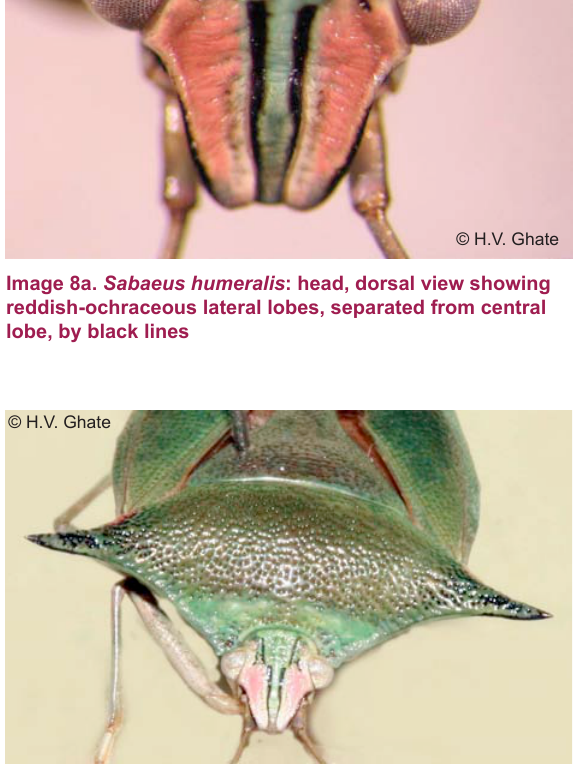
parts of scutellum, are dark black. The area between punctures shining green, almost like beetle elytra. Spines of the lateral pronotal angles are green with black tips and possess a reddish ochraceous spot at the posterior margin (Image 9). Ventrally these spines are smooth, pale green and with black tips (Image 10). Scutellum narrowed towards apex. Corium dark green, hemelytral membrane translucent pale green. Ventral side is light green in lateral parts, pale cream in the median region, especially in abdominal area. Legs are pale green. Fine, sparse punctures are present on some parts of the sternum. Mesosternum distinctly carinate. Rostrum green, except the tip which is black, reaching beyond the 2 nd abdominal segment. Tips of the posterior angles of each abdominal segment dark black and produced as a minute spine (Image 11). A short, obtuse ventral abdominal spine is present on II